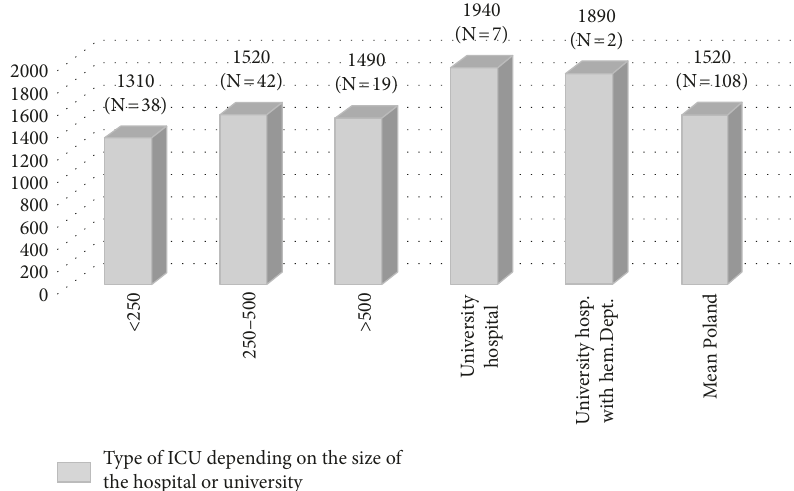
Figure 1: Mean antibiotic consumption in Polish ICUs (data expressed in DDD/1000 patient-days).